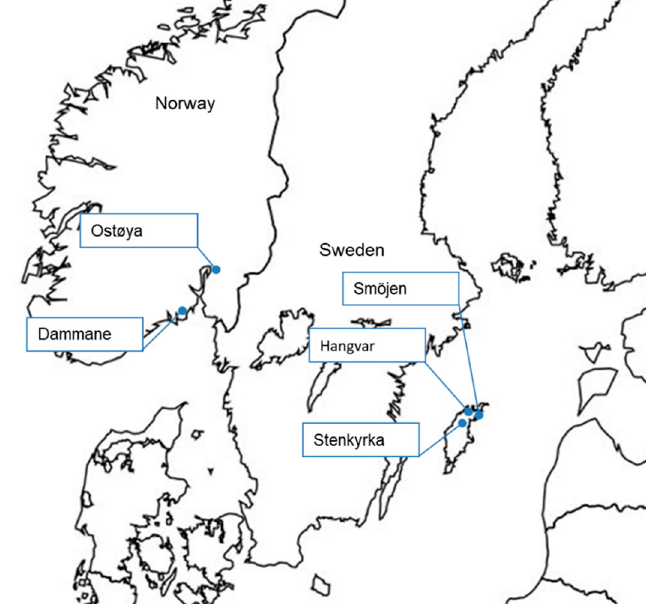
Figure 2. The locations of biocide treatments against signal crayfish in Norway and Sweden (see Table 1).